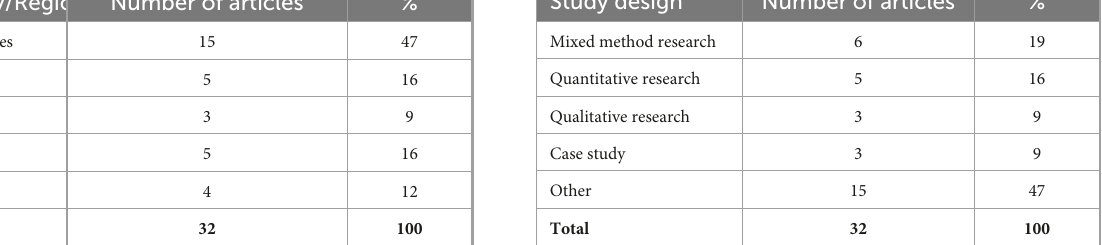
TABLE 3 Distribution by country/region. Country/Region Number of articles